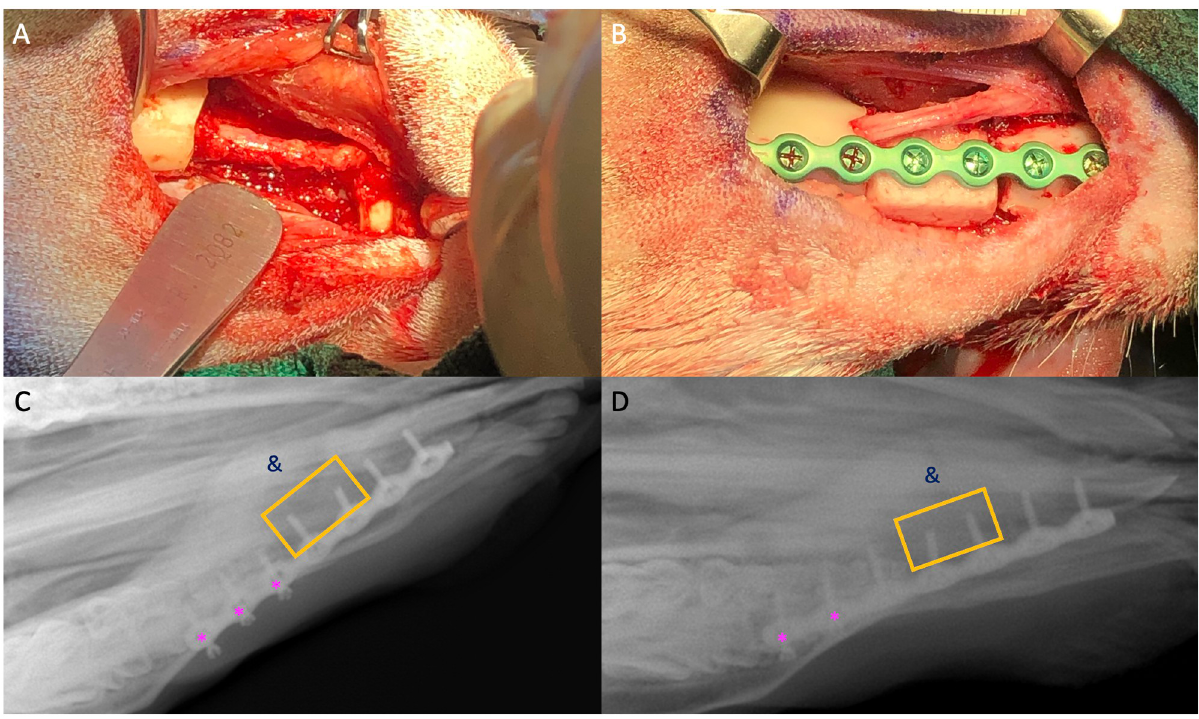
Fig 1. Successful space maintainer implantations with single lateral plate. The creation of the defect showing preserved mental nerve (A); the space maintainer was shaped to the defect, and a groove was placed anteriorly for the nerve to run across (B); and X-rays showing position of space maintainer (yellow box), medial callus formation (&), and loosening screws (pink asterisks) for two different sheep